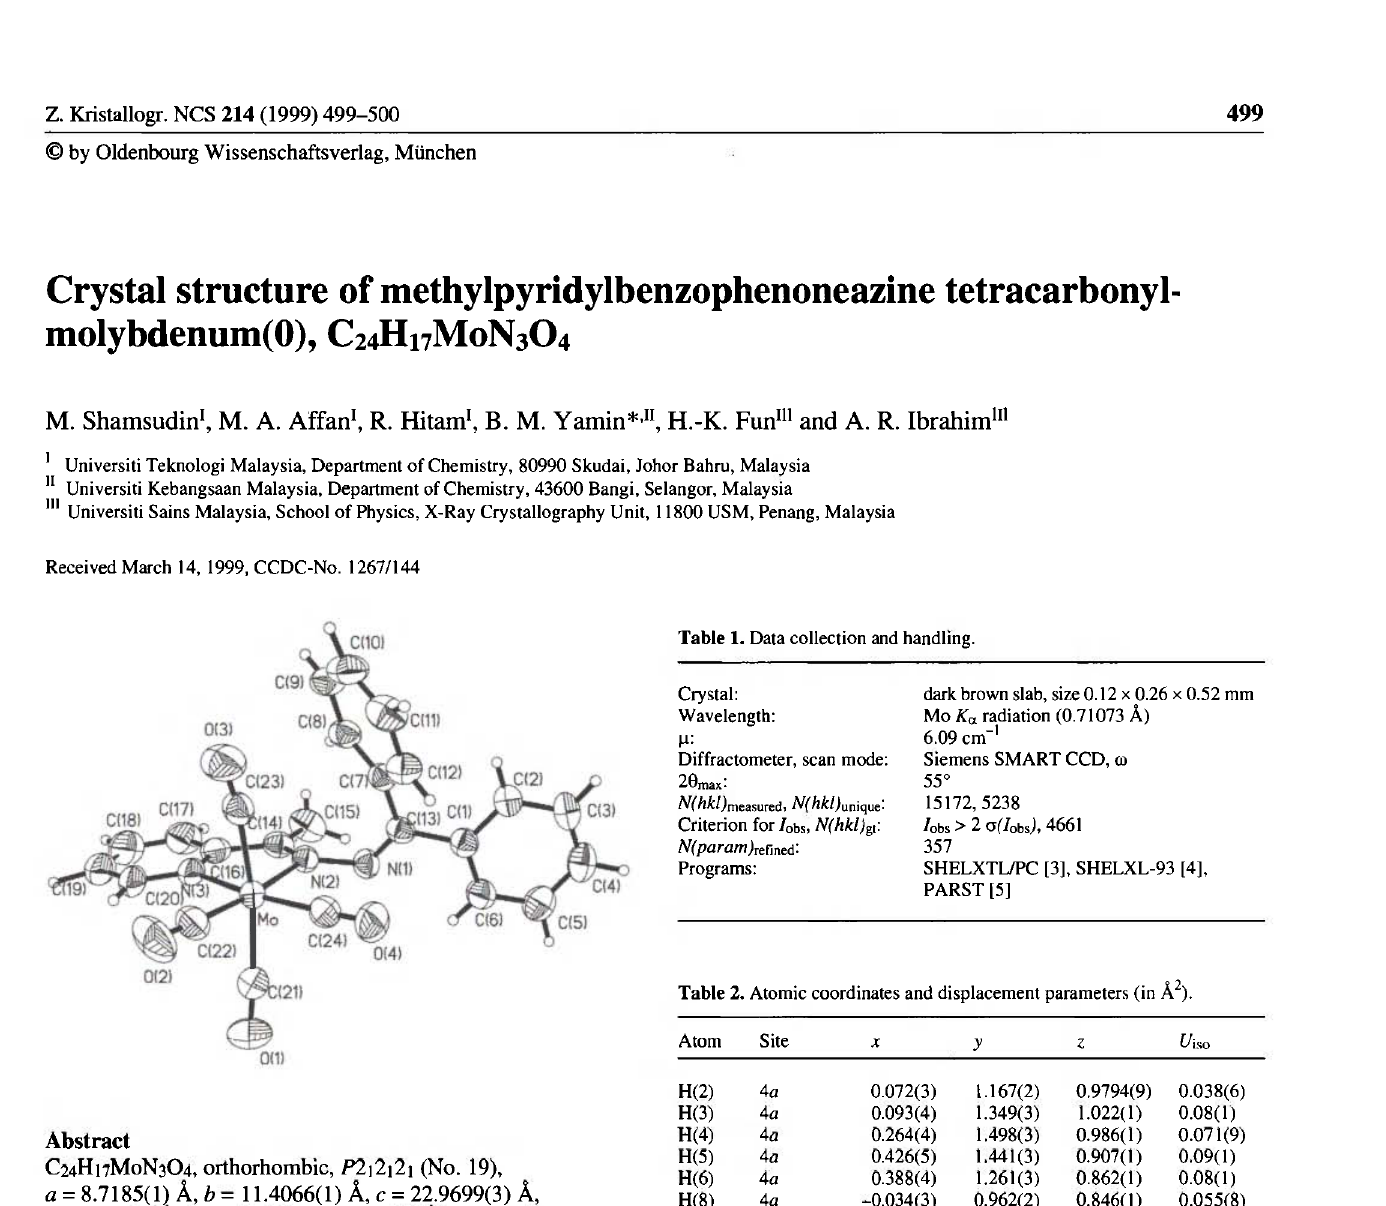
Table 2. Atomic coordinates and displacement parameters (in Ä 2